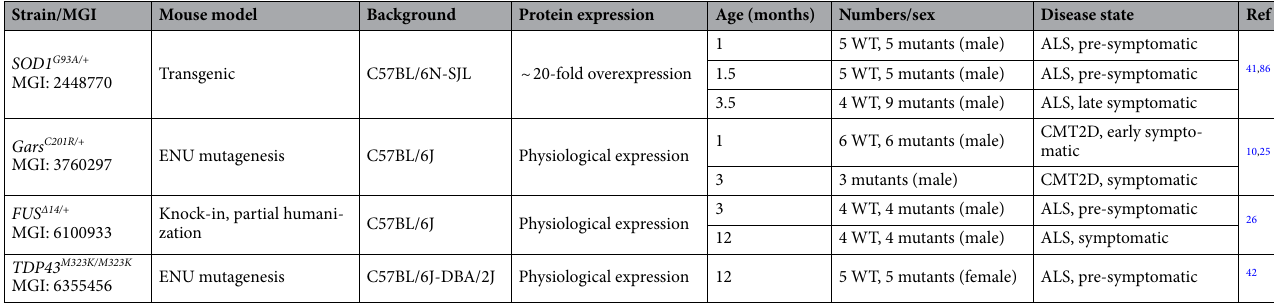
Table 1. Summary of mutant mice. MGI Mouse Genome Informatics number.